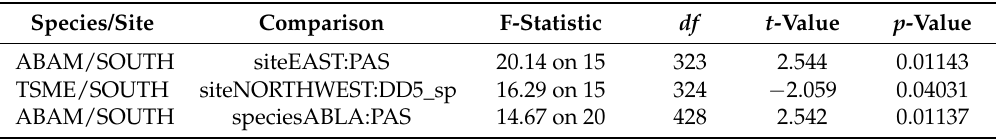
Table A2. Test statistics for the pairwise differences that revealed significantly different climate sensitivities, either between two species at a site, or two sites for the same species. A. amabilis was set as the intercept for comparisons between species at a site, and the south (snowiest) side was set as the intercept for comparisons between sites. PAS = precipitation as snow, DD5_sp = spring growing degree